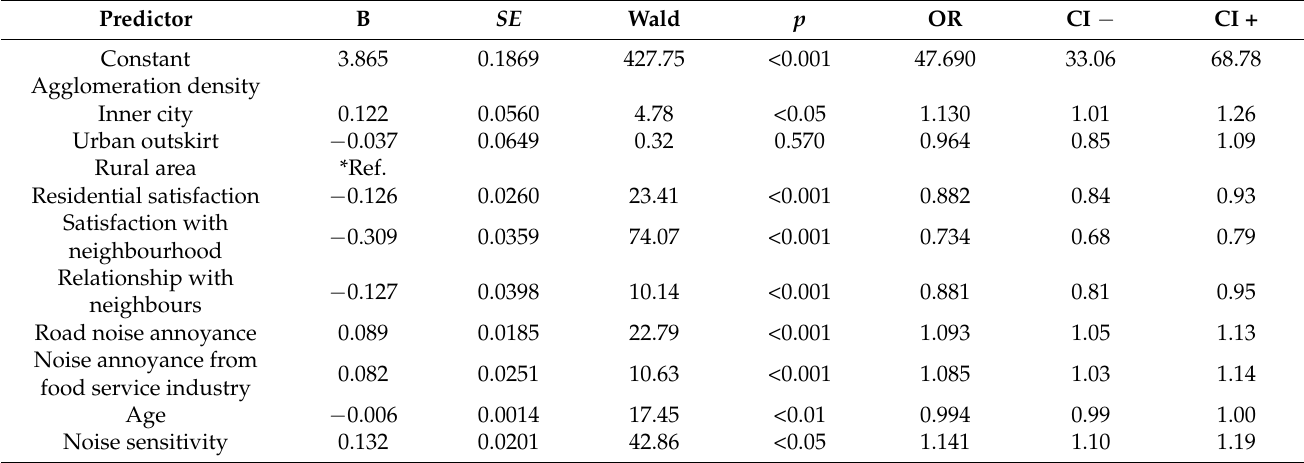
Table 4. Results of GZLM regressions for the analysis of predictors of neighbour noise annoyance.